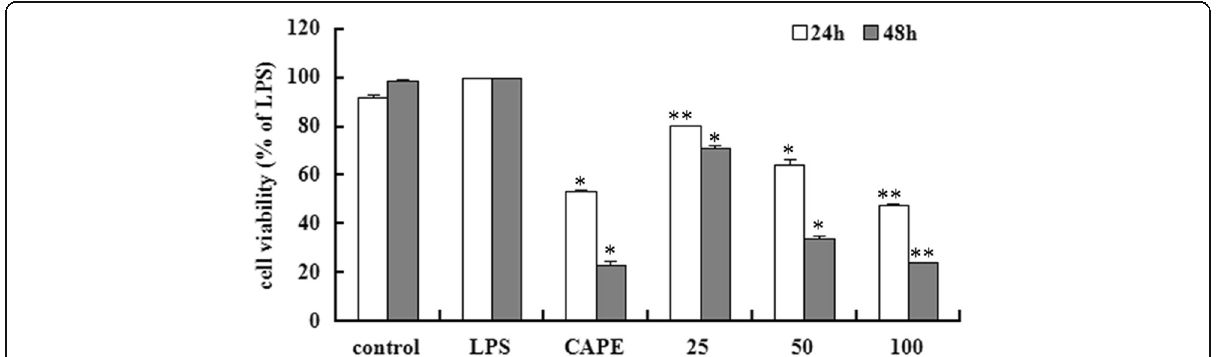
Fig. 2 EECP and CAPE decreased LPS-stimulated MDA-MB-231 cells proliferation at 24 and 48 h. CAPE, cells treated with CAPE at 25 μ g/mL. 25, 50 and 100 μ g/mL, cells treated with EECP at 25, 50 and 100 μ g/mL, respectively. ( * P < 0.05, ** P < 0.01 vs control, n = 3). Data are means ±